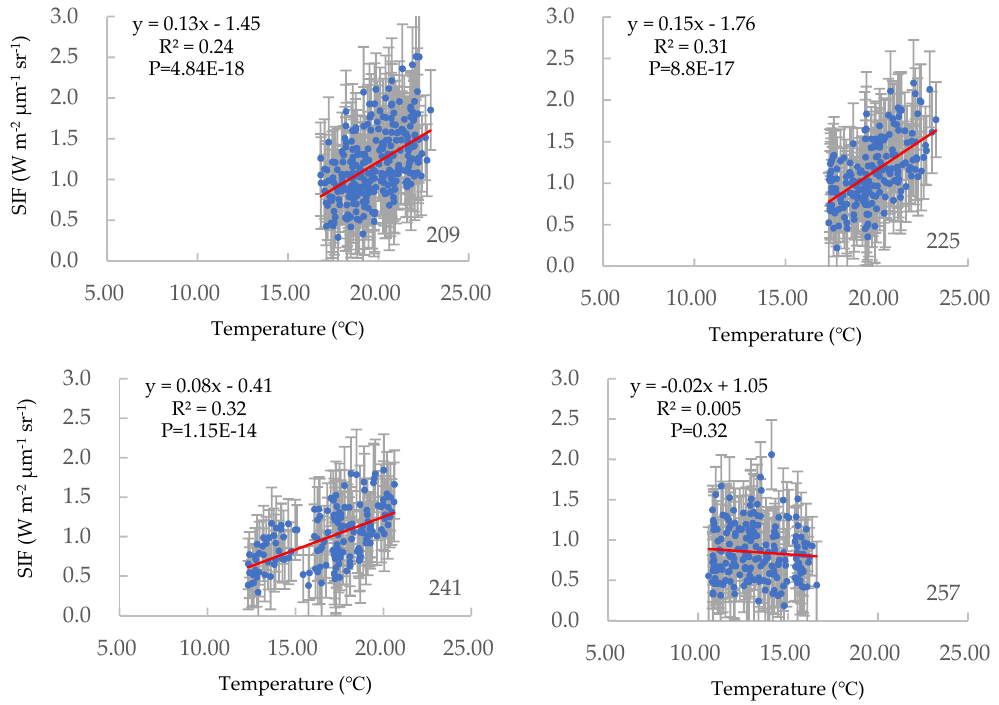
Figure 10. Scatter plot between SIF and temperature at a 16 ‐ day time scale.